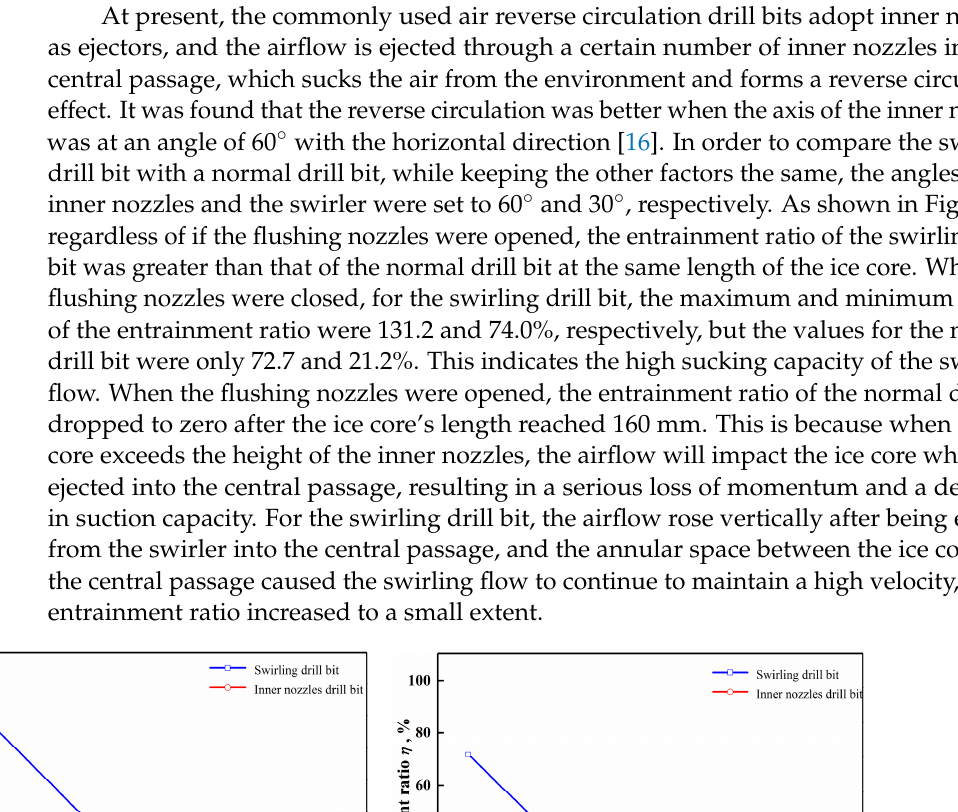
Figure 12. Pressure distribution along different plane position: ( a ) drill bits without flushing nozzles; ( b ) drill bits with flushing nozzles.